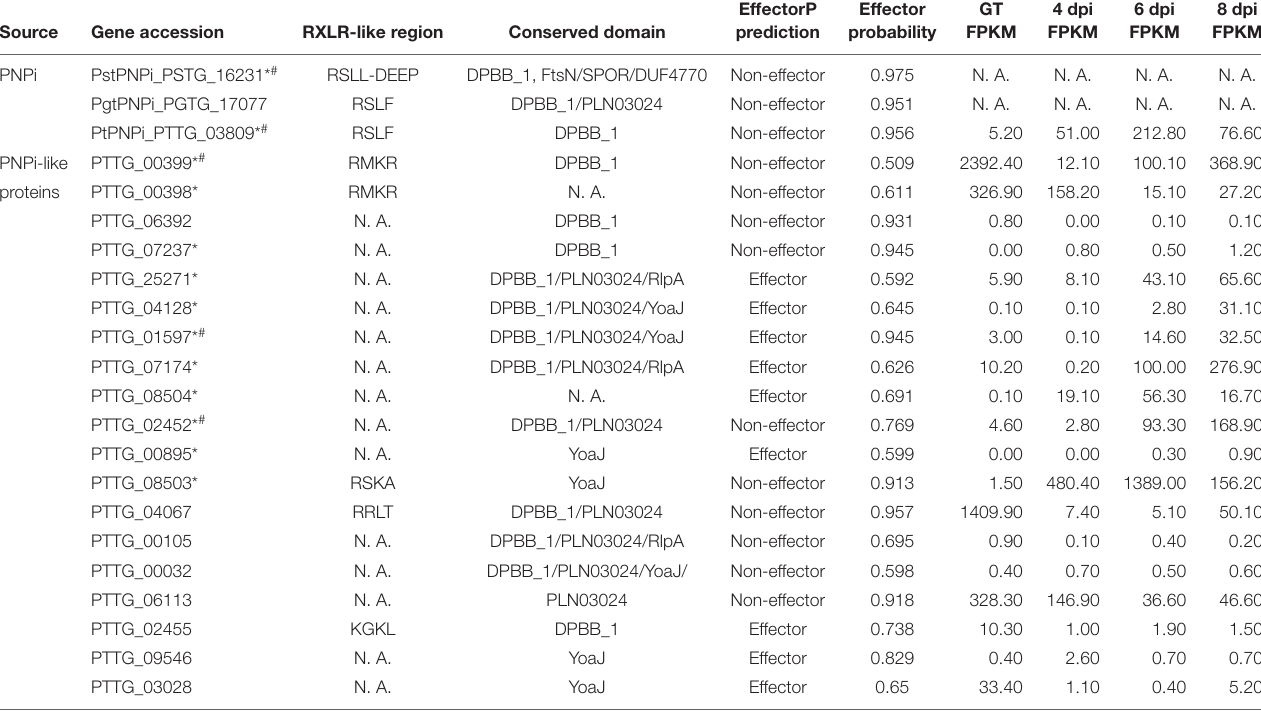
EffectorP Effector